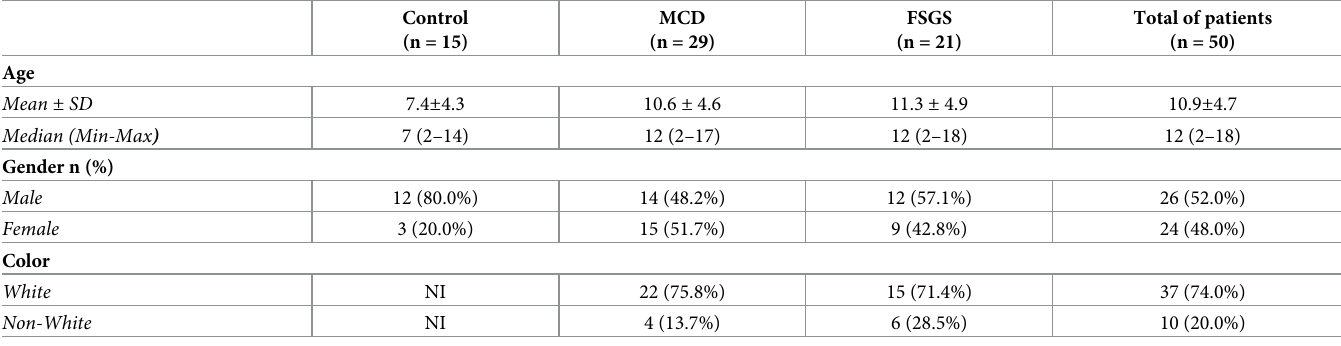
Table 1. Epidemiological data on cases of MCD, FSGS and control